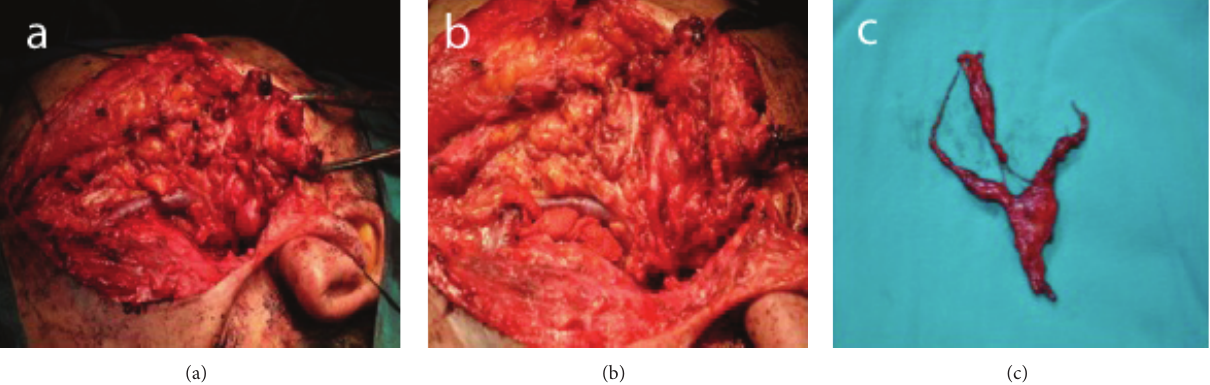
Figure 2: (a) The intraoperative view of the tumoral mass after explosion of the main trunk of facial nerve. (b) It is clearly seen after frozen section from the center of the mass that the tumor was surrounding the temporozygomatic branches of the facial nerve. (c) The postoperative view of the tumor after